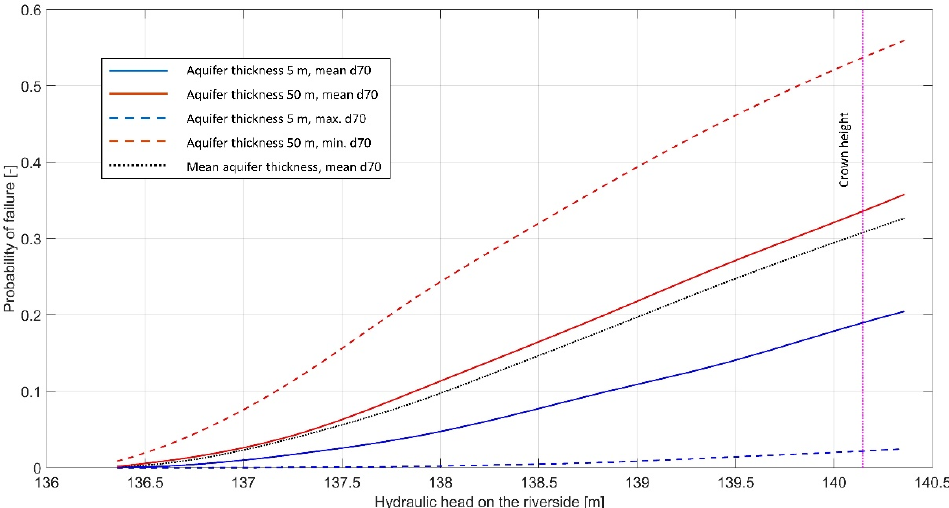
Figure 11. Probability of piping failure for piping design case 1 (PDC1).